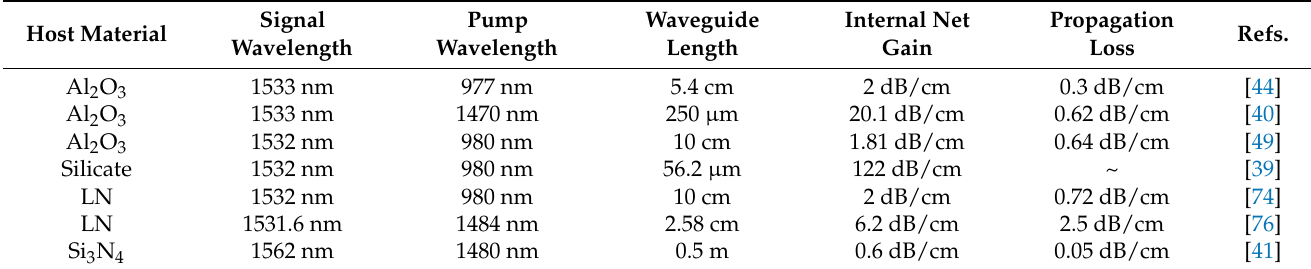
Table 1. Comparison for representative on-chip Er-based waveguide